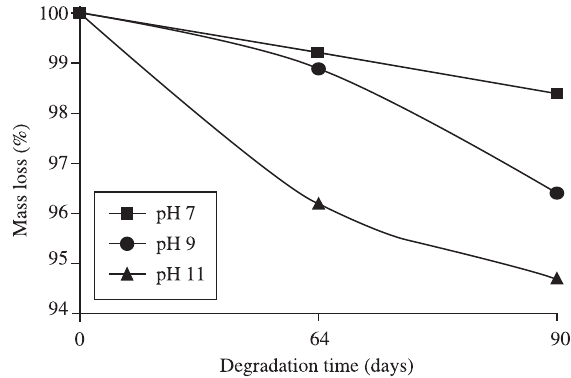
Figure 5. PHB mass loss due to accelerated degradation.